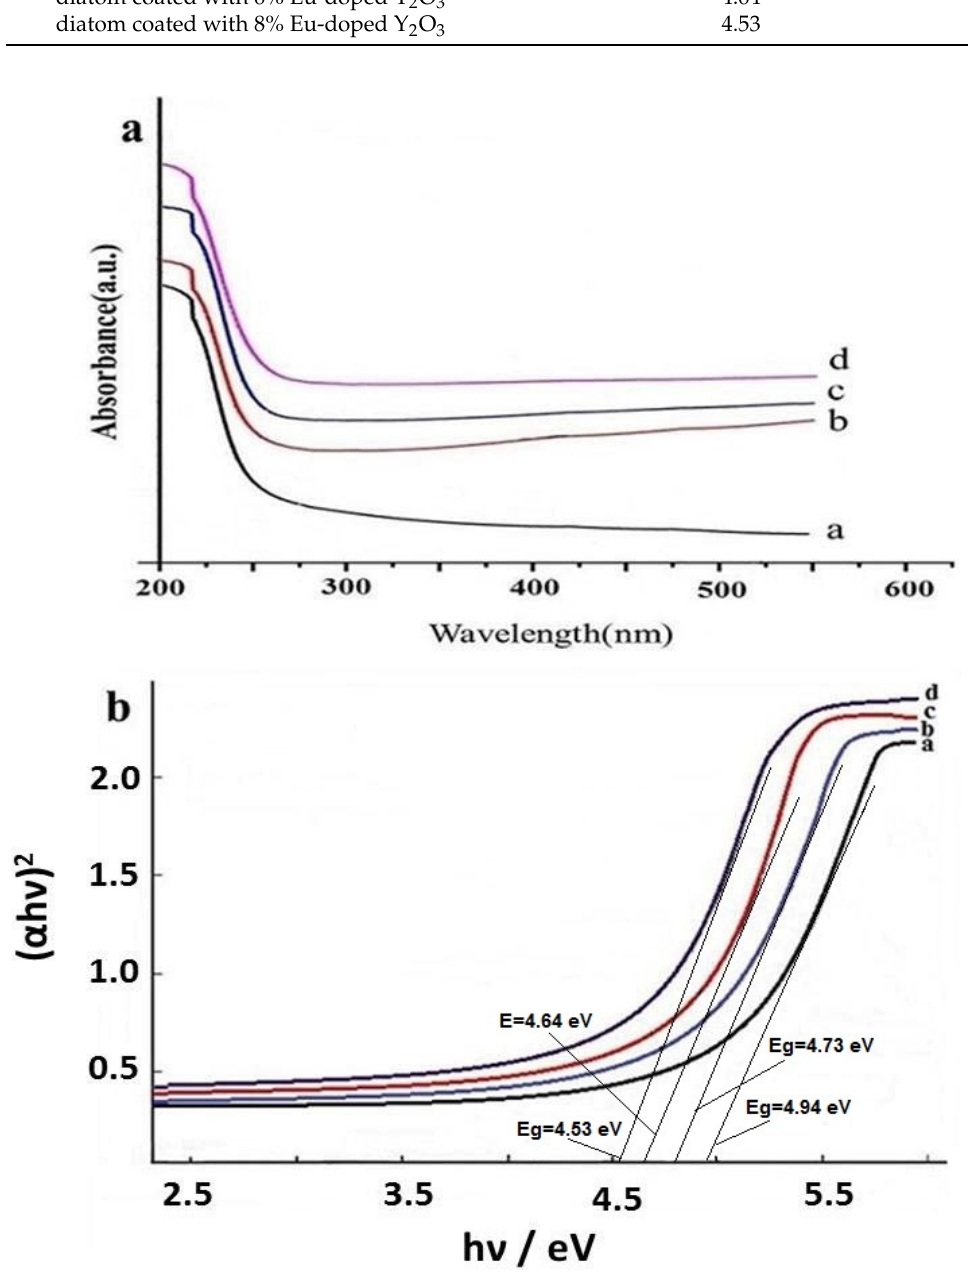
Figure 6. ( a ) Absorbance spectra and ( b ) Tauc plot of diatom coated with Y 2 O 3 (a), 4% Eu-doped Y 2 O 3 (b), 6% Eu-doped Y 2 O 3 (c), 8%Eu-doped Y 2 O 3 (d) at room temperature. Eu-doped Y 2 O 3 samples (Eu x Y 2-x O 3 ). Under UV irradiation, the samples present a strong emission centered at 614 nm, and other emission feature is an indication of